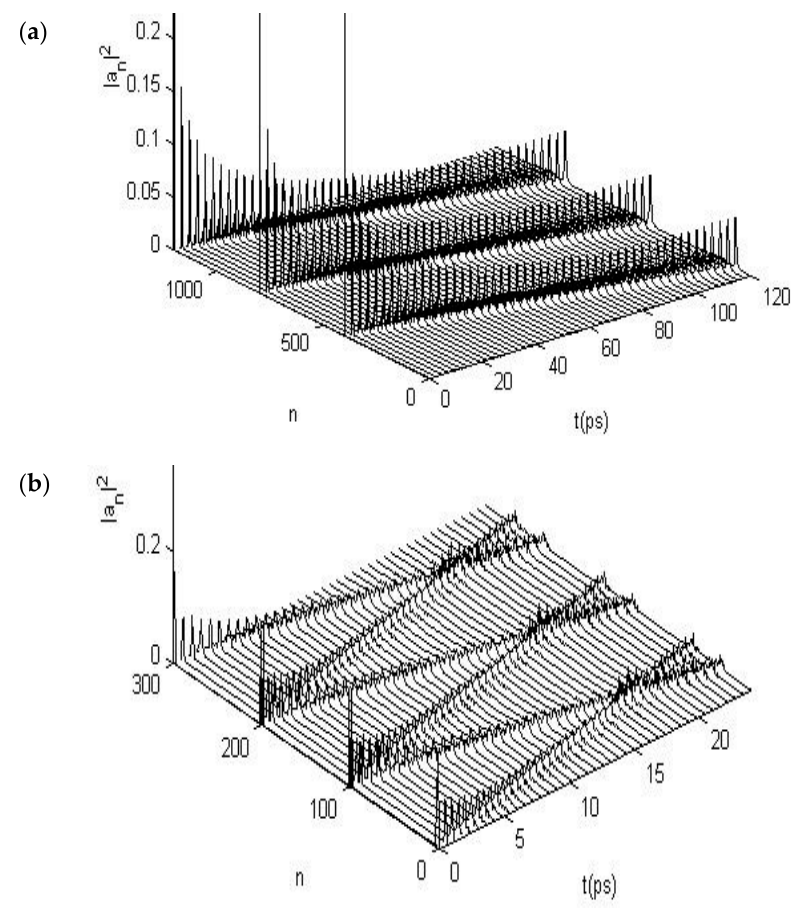
Figure 5. States of ( a ) movement and collision features of ( b ) Pang’s solitons in uniform α -helix proteins.